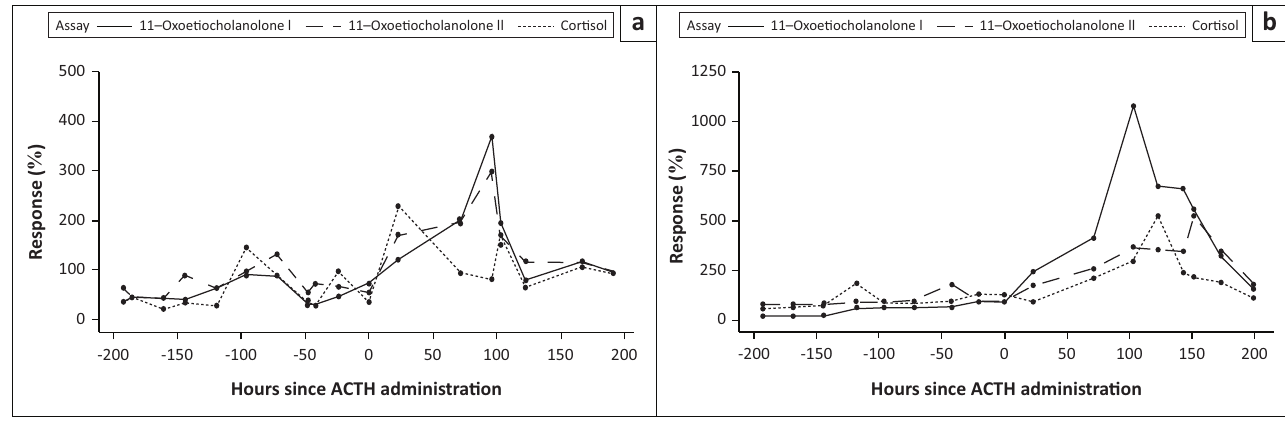
FIGURE 1: The longitudinal faecal glucocorticoid metabolite response for both male (a) and female (b) study animals following adrenocorticotropic hormone administration (time: 0) and separation or injury. TABLE 1: Male baseline faecal glucocorticoid metabolite concentrations, as well as the mean absolute deviation from baseline, for all three enzyme immunoassays employed during the study. Male Baseline fGCM (EIA) (fGCM